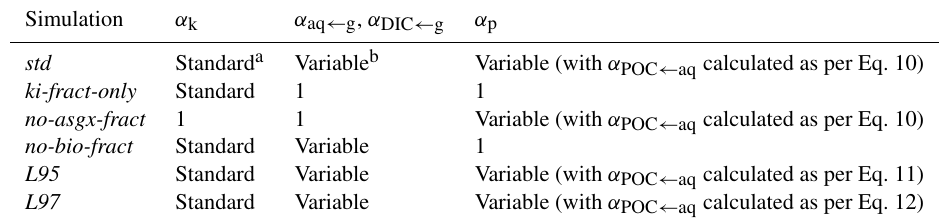
Table 2. Overview of the fractionation factors used in the sensitivity experiments. Simulation α k α aq ← g , α DIC ← g α p std Standard a Variable b Variable (with α POC ← aq calculated as per Eq. 10) ki-fract-only Standard 1 1 no-asgx-fract 1 1 Variable (with α POC ← aq calculated as per Eq. 10) no-bio-fract Standard Variable 1 L95 Standard Variable Variable (with α POC ← aq calculated as per Eq. 11) L97 Standard Variable Variable (with α POC ← aq calculated as per Eq.